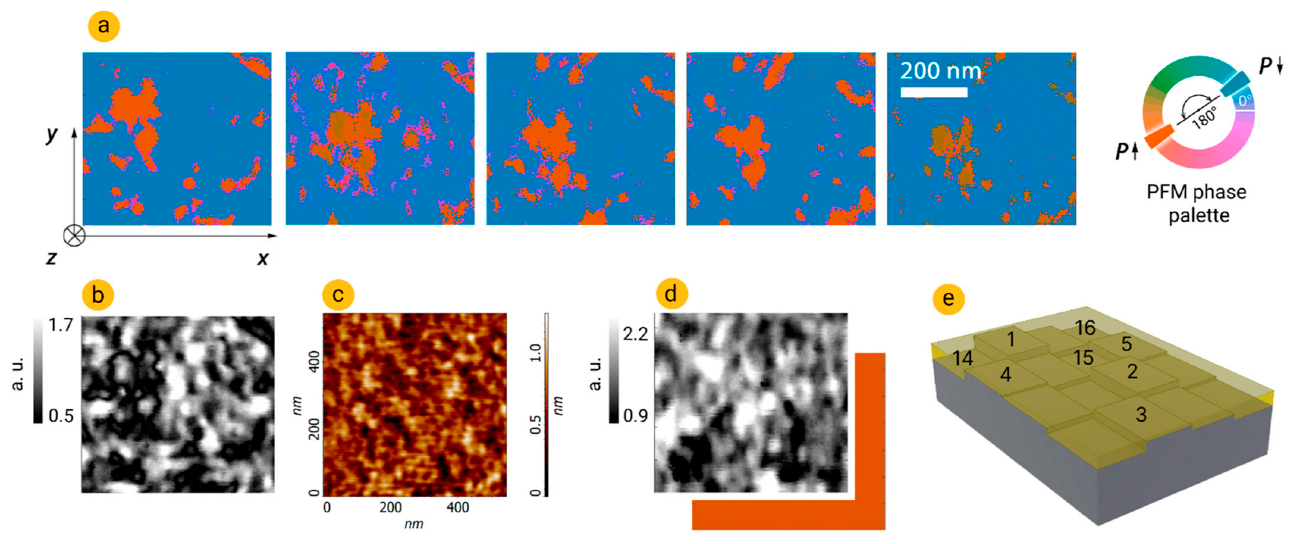
Figure 4. Examination of the statistical domain switching. ( a ) Domain structure (PFM phase maps) after five identical switchings by set pulse − 1 V/100 µ s. ( b ) PFM amplitude map and ( c ) topography of top electrode surface corresponding to PFM phase map above it. ( d ) Domain structure (overlapped PFM amplitude and phase maps) at monodomain state after applying − 3 V. ( e ) Schematic repre- sentation of the domain structure of a ferroelectric with a variation in ferroelectric and dielectric thicknesses. The numbers denote the sequence of domain polarization